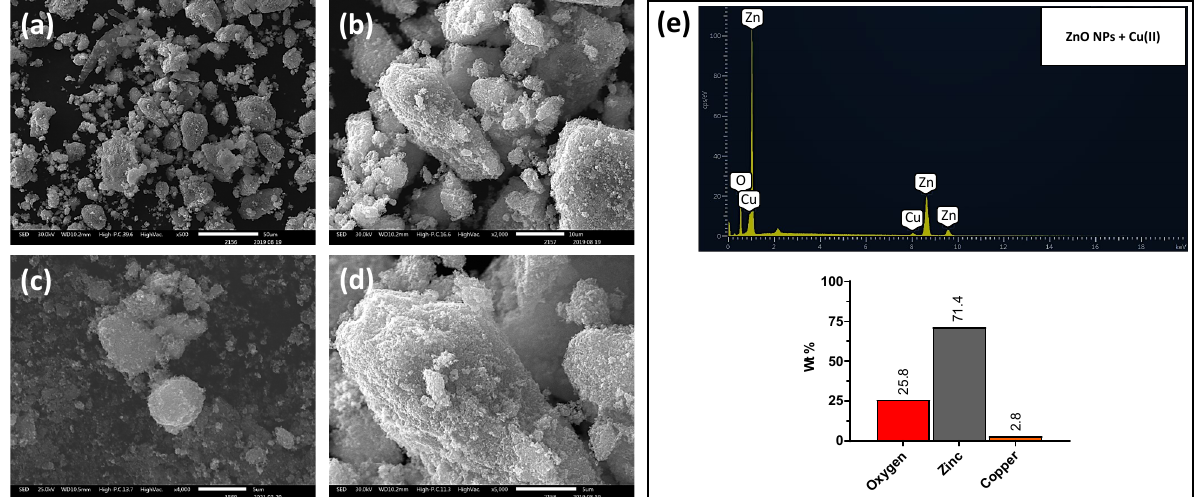
Figure 8. ( a – d ) Scanning electron micrographs after adsorption of Cu(II) ions (pH =4.0). ( e ) SEM-EDX spectra and elemental mapping (atomic percentage %) of ZnO NPs after adsorption of Cu(II) ions. The magnifications shown in SEM images were 500× ( a ), 1000× ( b ), 5000× ( c ) and 10,000× ( d ). Table 1. Parameters for the Langmuir, Freundlich and Temkin isotherm models for Cu(II) adsorption performed under two pHs. Langmuir Freundlich